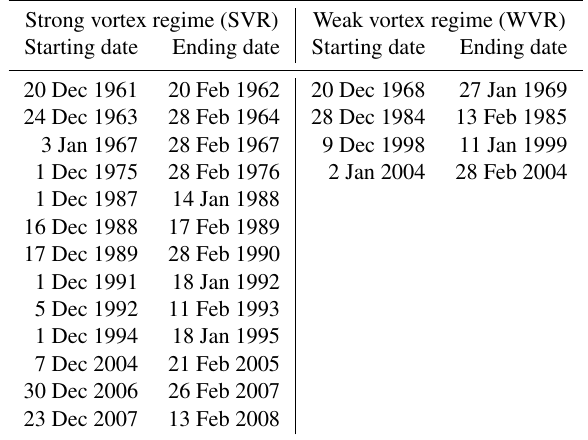
Table 2. Periods of polar vortex regimes lasting for at least 30 con- secutive days in DJF; left: strong vortex regime. Right: weak vortex